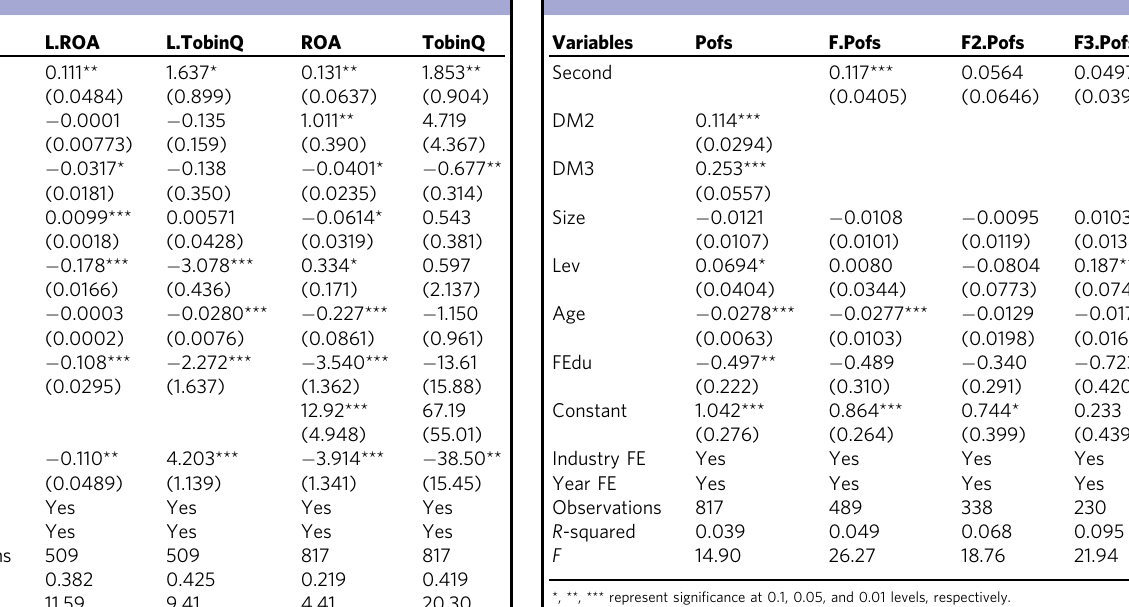
Table 9 Further analysis of the employment of female Table 8 Endogenous test of female employment and fi rm